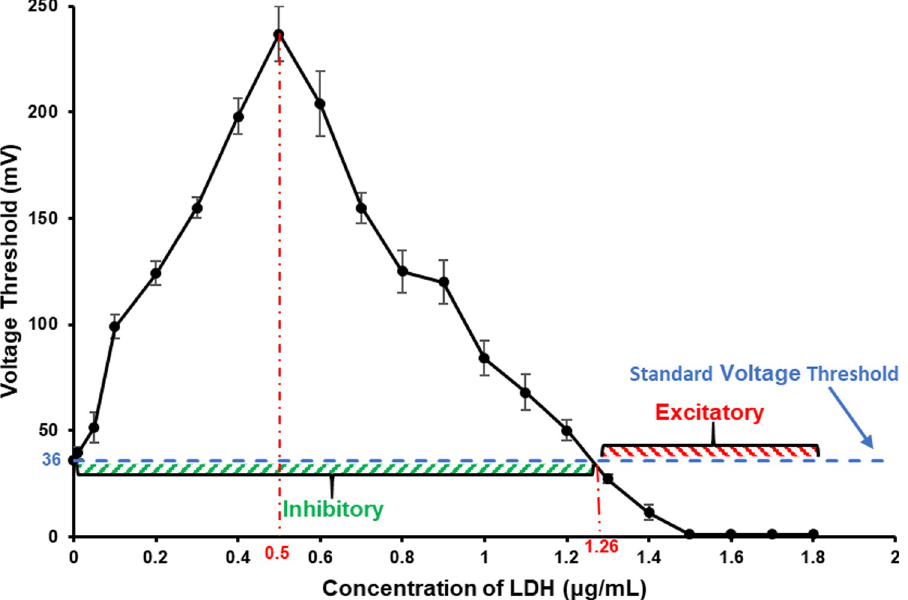
Fig 6. The V Th of PC12 quasi-neuronal networks under the effect of LDH in different concentrations ( n = 5). Blue dash line represents the normal V Th . The turning point of the effect of LDH from inhibitory to excitatory was at about 1.26 μ g/mL which was calculated by linear fitting the two data points next to the turning point in the experiment.